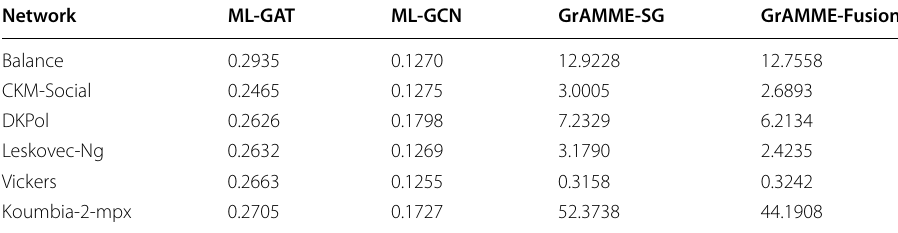
The training was performed on Google Colab with Tesla T4 GPU with the same hyperparameter setting described in "Experimental settings" section